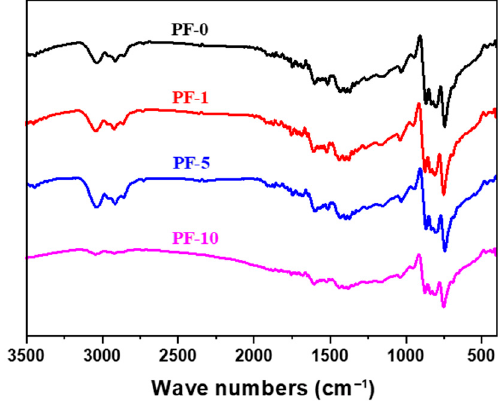
Figure 3. FT-IR spectra of PIM-derived pitch fibers.